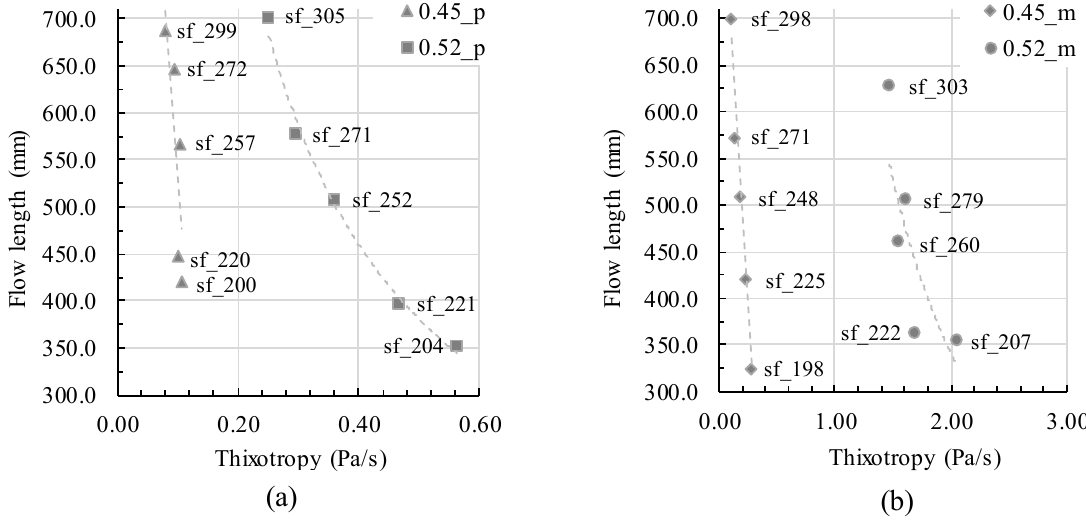
Figure 9. Flow length depending on thixotropy for ( a ) paste series and ( b ) mortar series with an indication of the slump flow value for each sample.